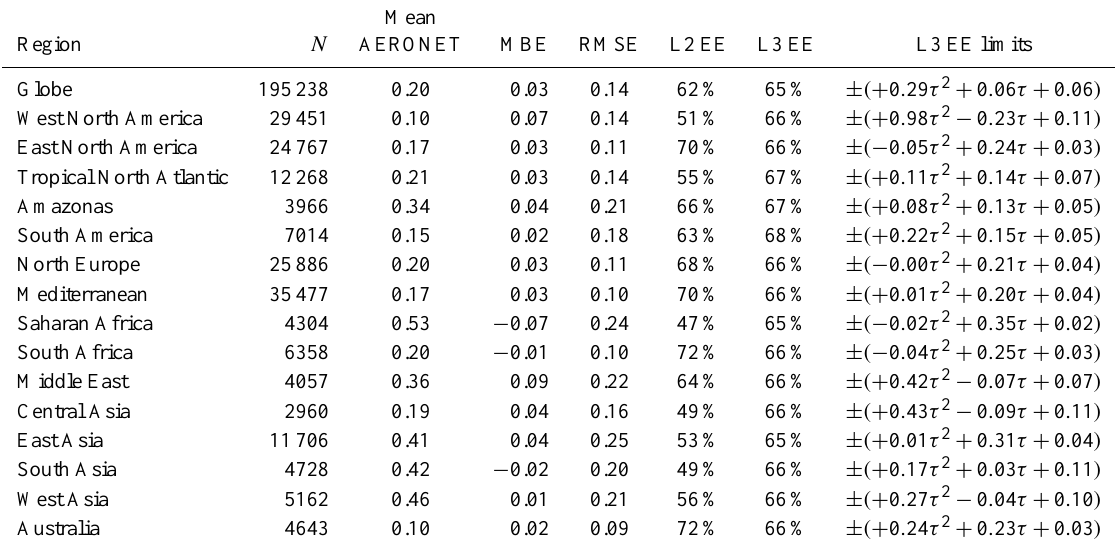
Table 1. Summary statistics for the entire dataset and each individual region: number of samples ( N ), mean AERONET AOD, MBE and RMSE in AOD unit, fraction of data points within the L2 and L3 AOD expected error intervals (L2 EE and L3 EE, respectively), and L3 AOD expected error limits